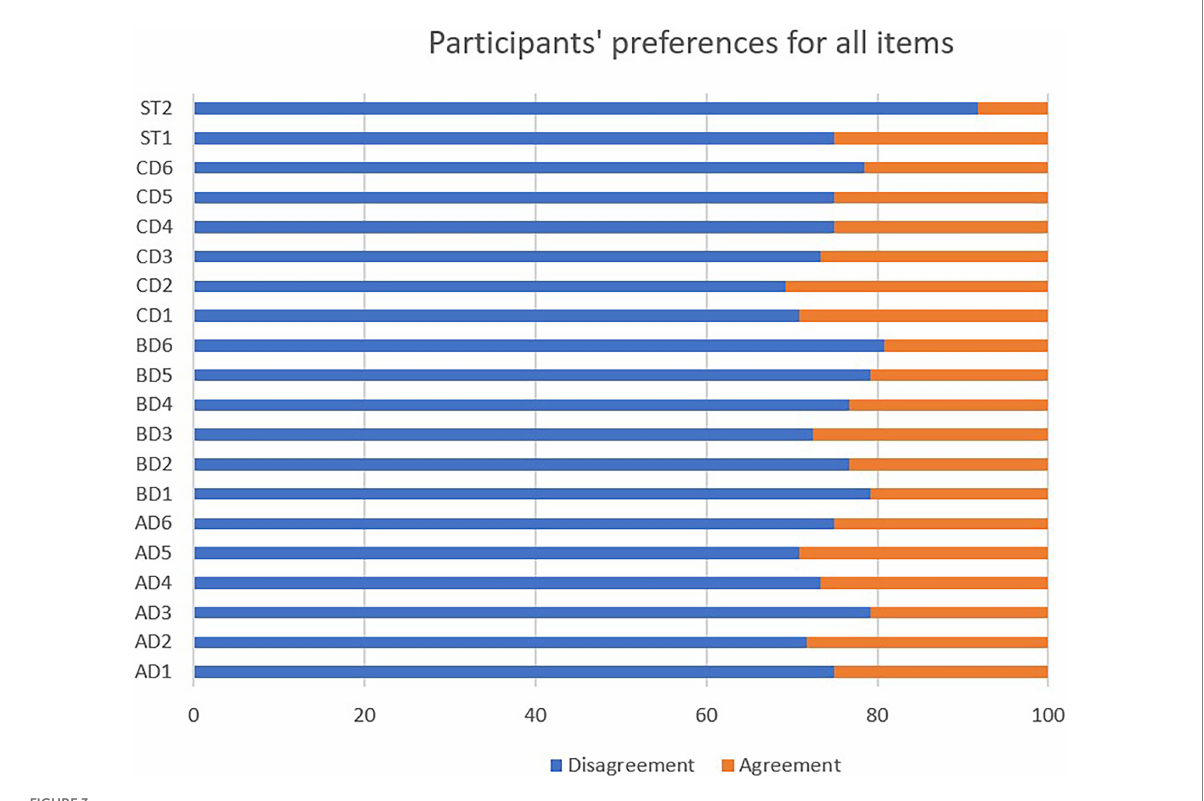
FIGURE 3 Participants’ preferences (%) on all items in the three components.